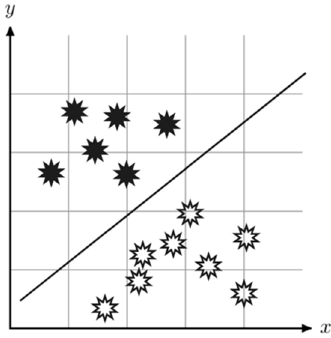
Figure 3. Support vector machine (SVM) principle.